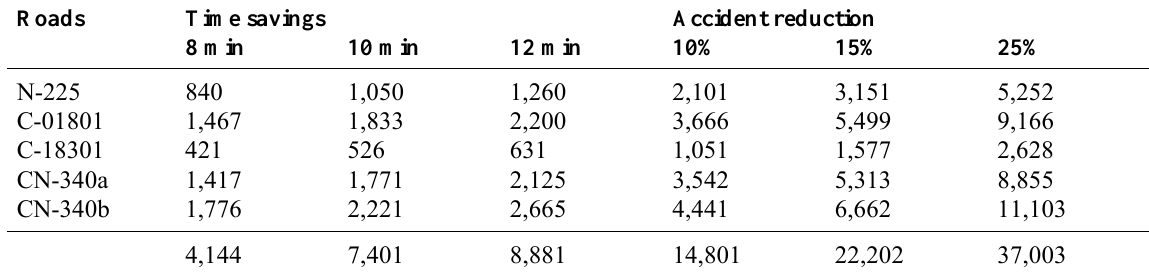
Table 6. Social benefits yielded by time savings and accidents reduction (thousands of euros per